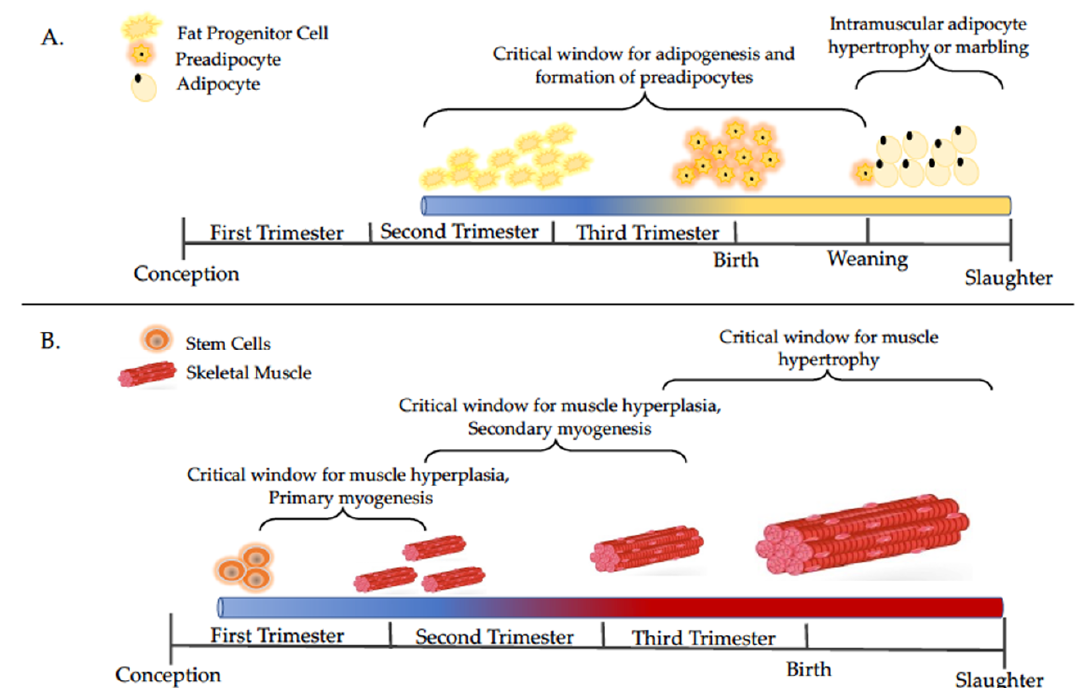
Figure 1. Timelines of adipocyte ( A ) and muscle ( B ) development with a focus on major events discussed in this review. Adapted from [14,17,18] .